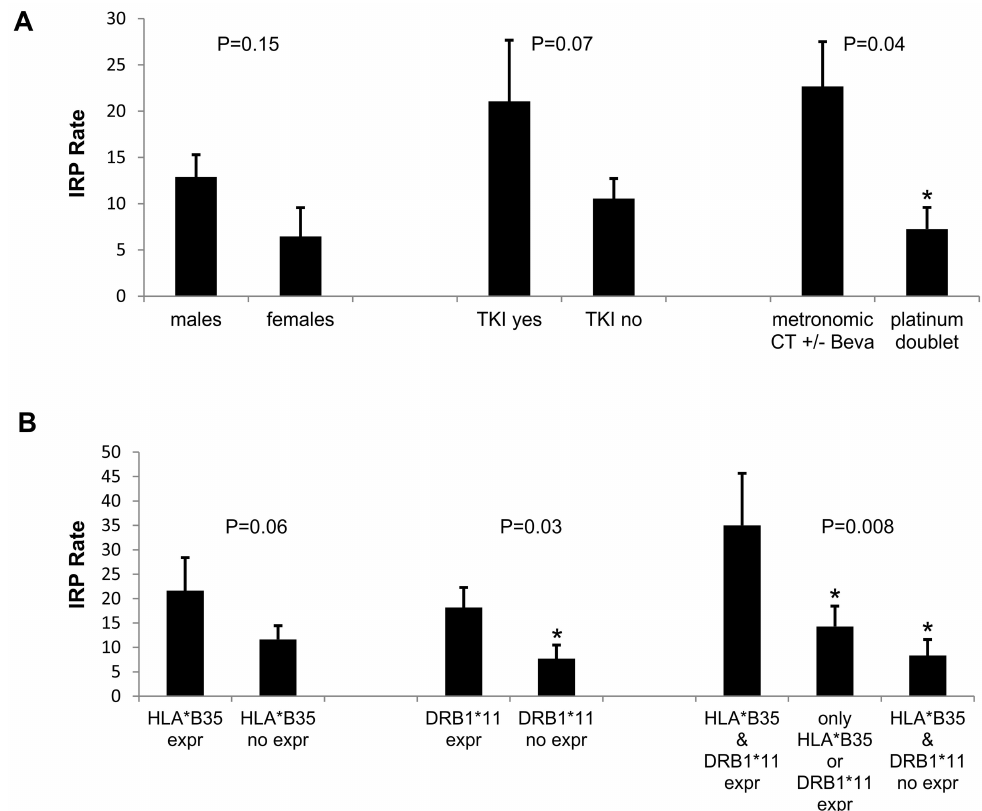
Figure 2. Rate of immune checkpoint inhibitor-related pneumonitis (IRP) in metastatic non-small-cell lungcancer(mNSCLC)patients. ( A )HistogramsrelativetotherateofIRPinpatientsstratifiedforgender (considering the whole population including also histology di ff erent from NSCLC), tyrosine kinase inhibitor (TKI) therapy, and metronomic chemotherapy with fractioned cisplatin and oral etoposide (mPE) / metronomic chemotherapy with fractioned cisplatin and oral etoposide + bevacizumab (mPEBev) regimen prior to PD-1 / PD-L1 immune checkpoint inhibitors. ( B ) Histograms relative to the rate of IRP in all of the evaluated patients compared in terms of positive expression of the HLA-B*35 allele alone, DRB1*11 allele alone, and both